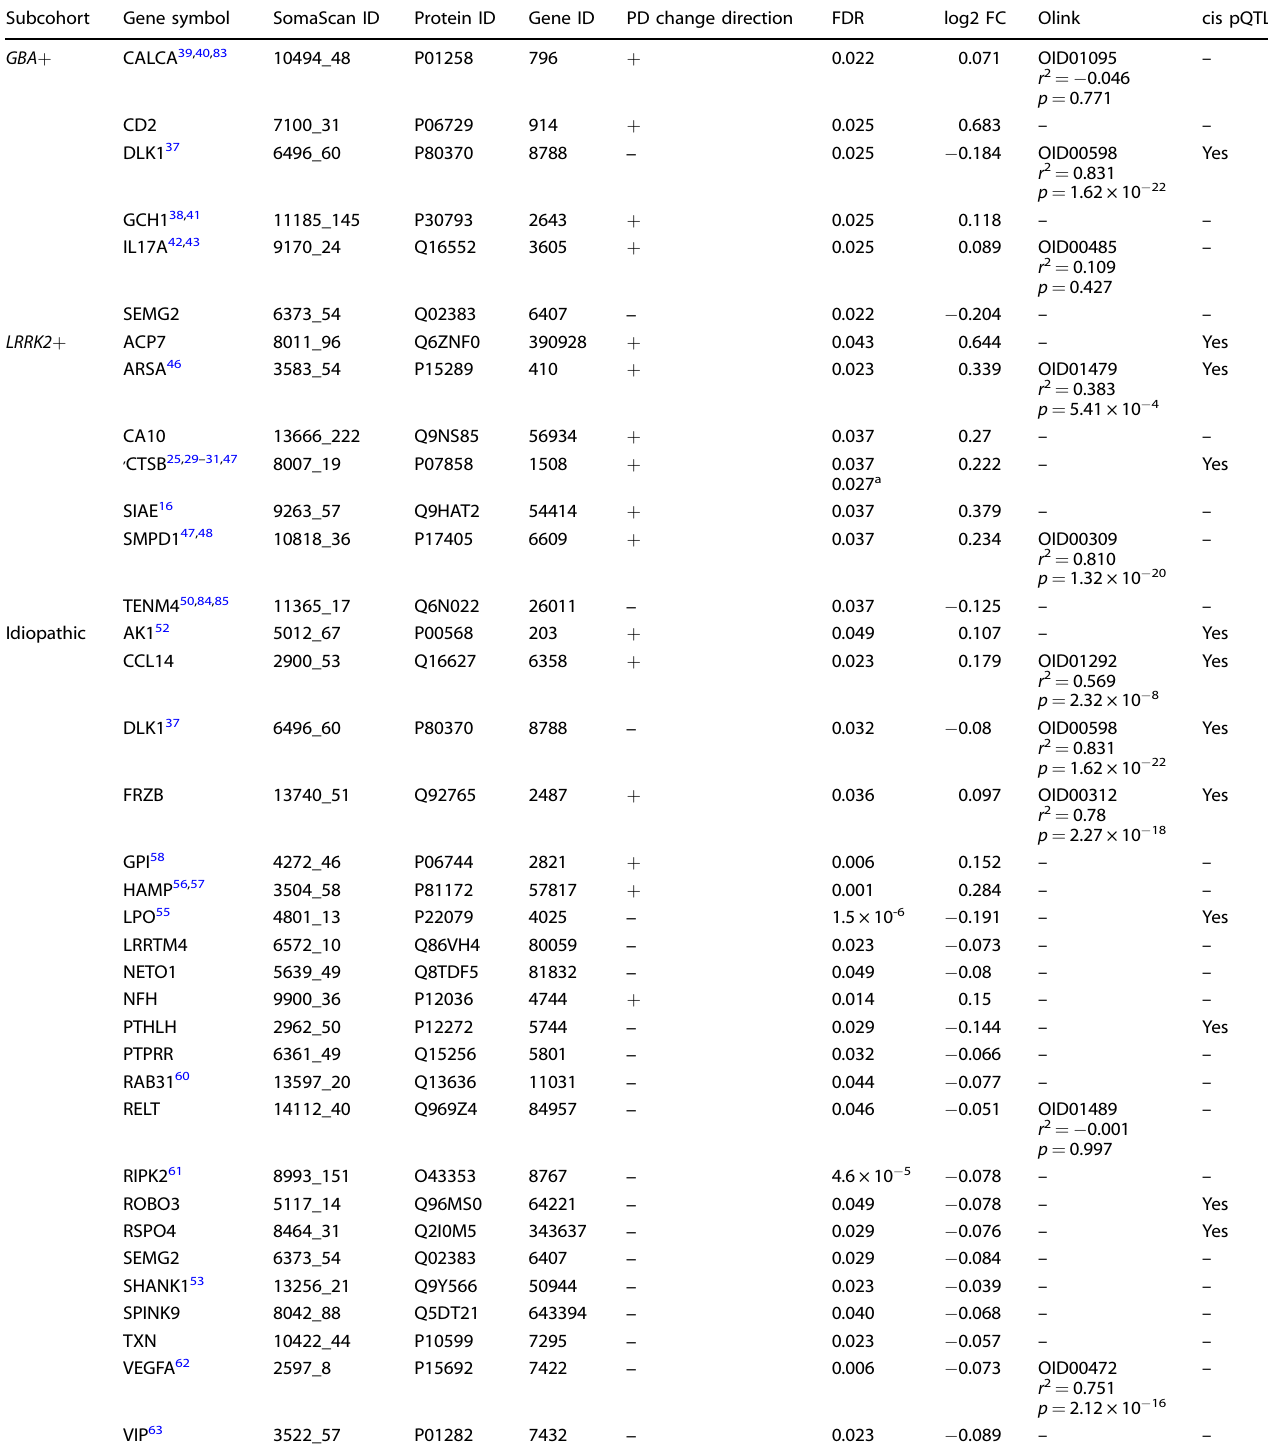
Table 3. SOMAmers differentially expressed between Parkinson ’ s disease patient vs. controls, divided by subcohort.